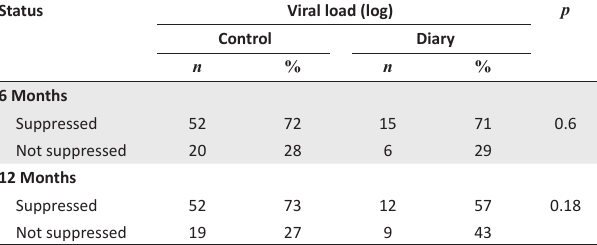
TABLE 2: Viral load response at 6 and 12 months for both